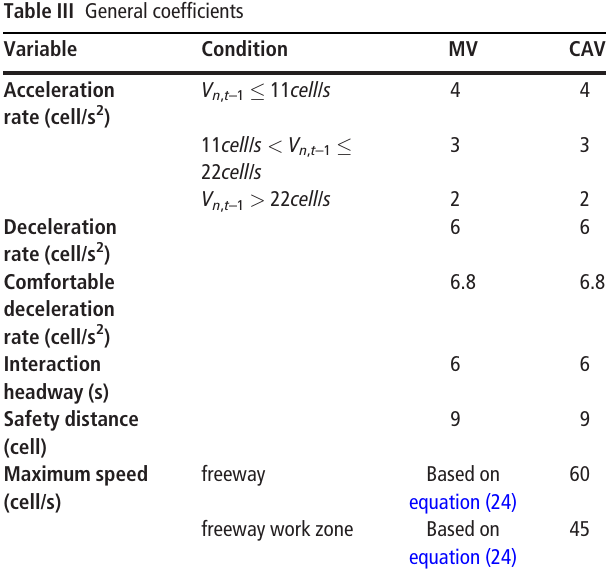
Table III General coef fi cients